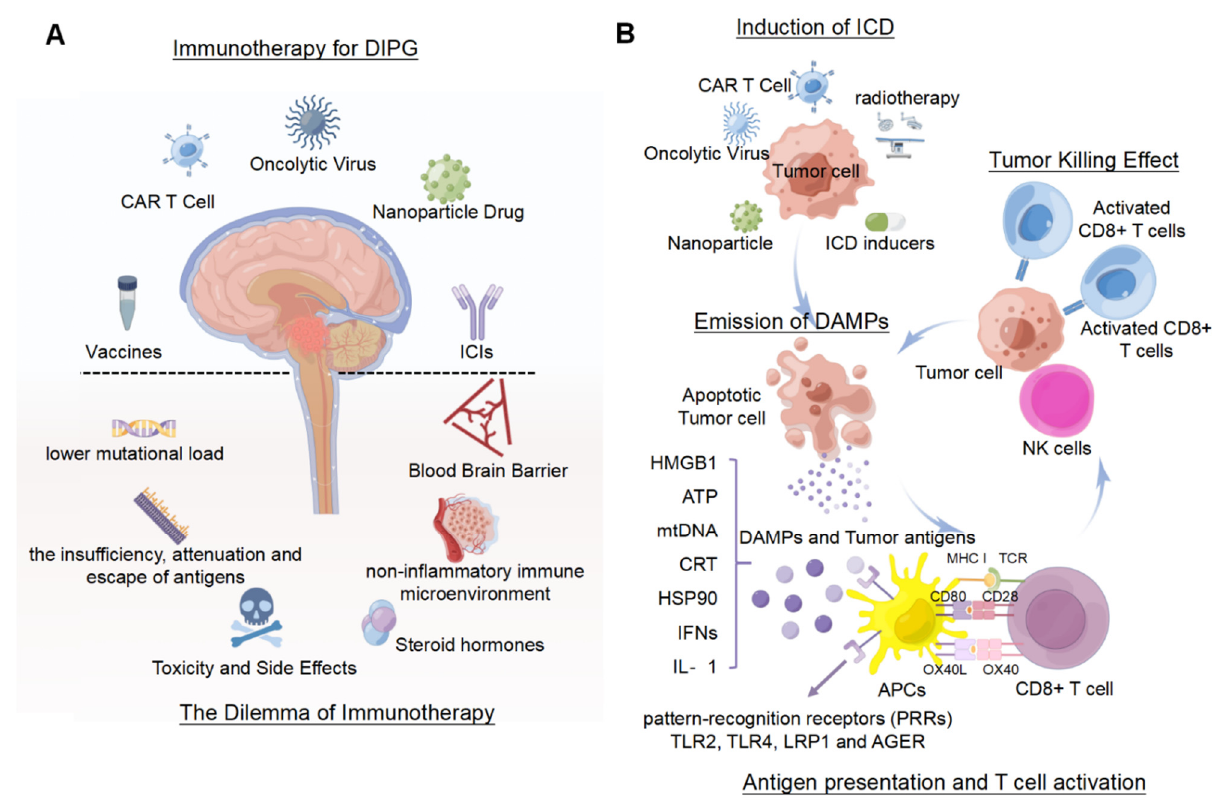
Figure 3. Types and dilemmas of immunotherapy for DIPG, and mechanisms by which immunogenic cell death enhances immunotherapy. ( A ) Cancer immunotherapy is based on the reactivation of anti-tumor immune responses and overcoming immune escape-related pathways. Current treatments utilize ICIs, CAR-T-cells, vaccines, and oncolytic viruses. The use of immunotherapy in DIPG is limited by a non-inflammatory immune microenvironment, lower mutational load, antigen insufficiency, attenuation and escape, toxicity of immunotherapy, blood brain barrier (BBB), and the use of cortisol. ( B ) ICD inducers can be combined with radiotherapy and immunotherapy for DIPG, resulting in cellular stress and cell death and the concomitant release of damage-associated molecular patterns (DAMPs), i.e., HMBG1, calreticulin, and ATP from dying tumor cells. Recruited dendritic cells assimilate the DIPG tumor antigens that are released from dying cells, such as HMGB1 binding to TLR2/4, which facilitates cytokine production and tumor antigen cross-presentation. The dendritic cells carrying DIPG antigens migrate to the cervical draining lymph node where they present the antigens to naive T-cells, thereby activating anti-DIPG effector T-cells. Primed effector T-cells migrate toward the tumor microenvironment and kill residual DIPG